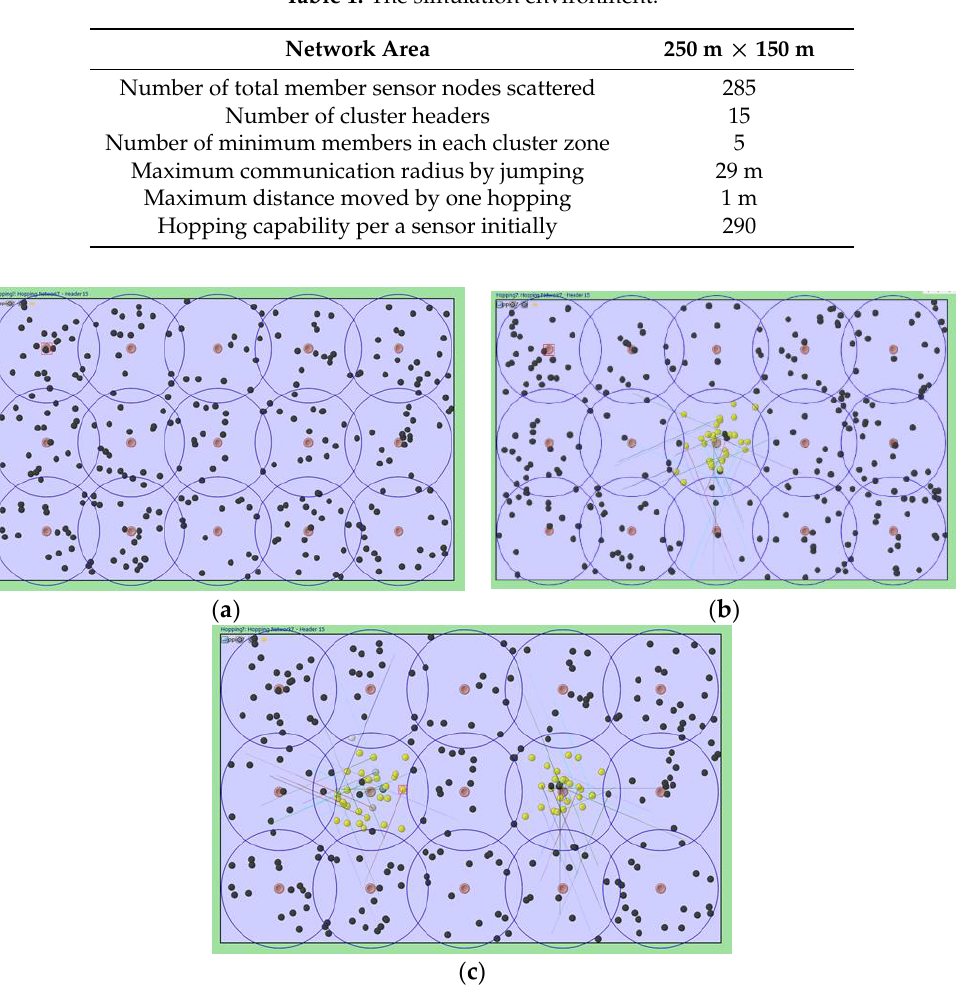
Table 1. The simulation environment.